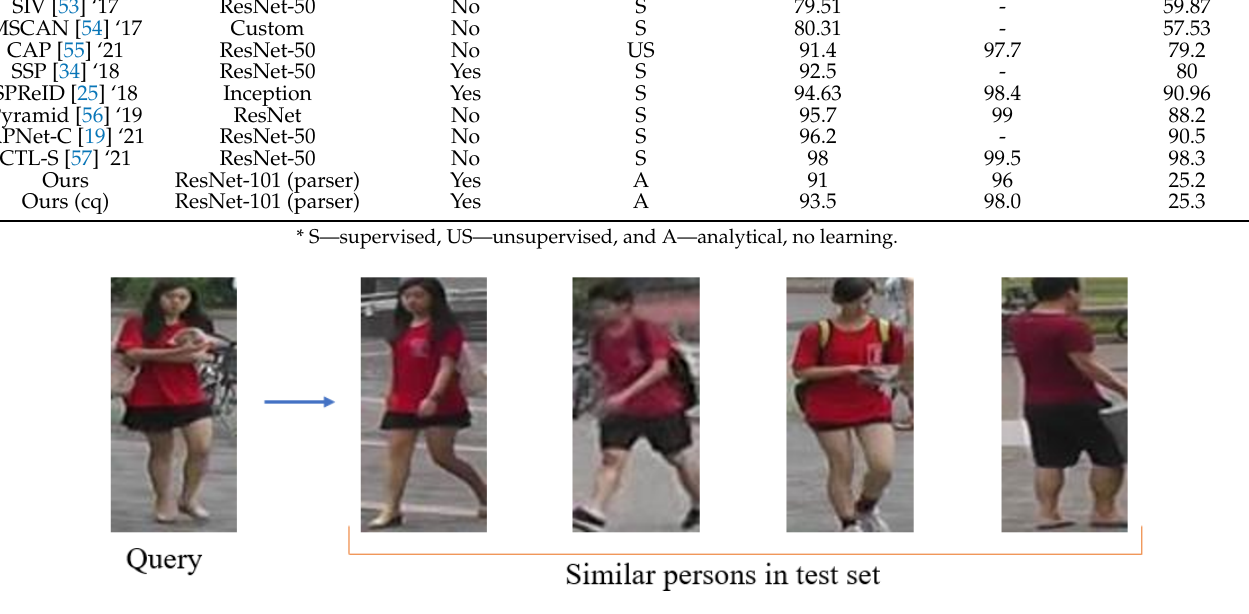
Figure 5. Similarly dressed people ( right ), in a test set of the Market1501 dataset, that have similar scores for a query ( left ), thereby resulting in a low mAP.